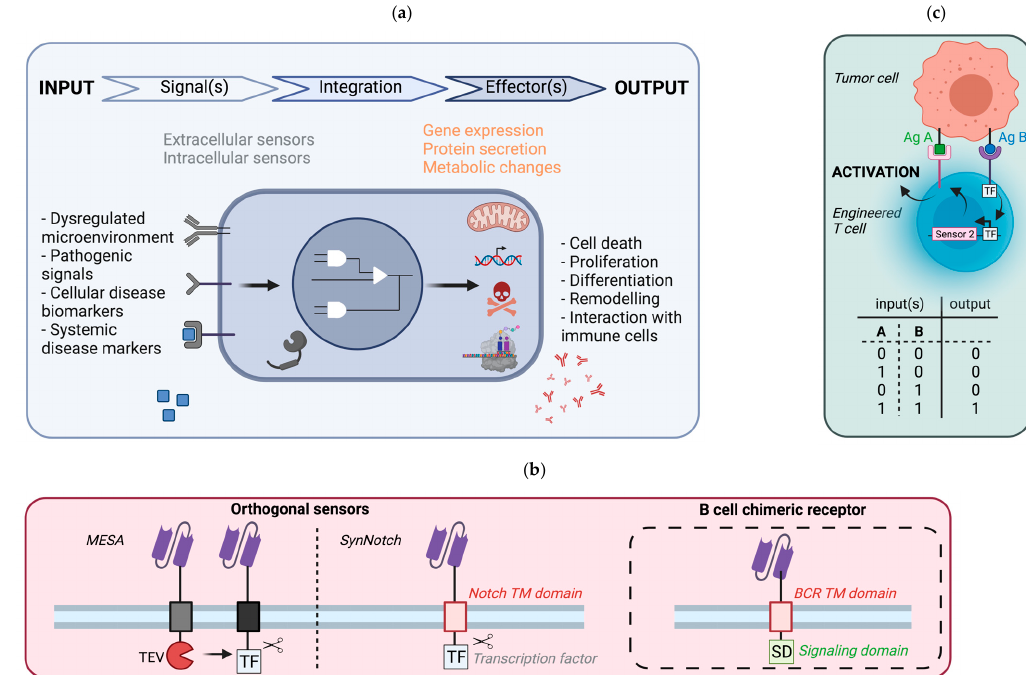
Figure 3. Synthetic immunology approaches applicable to B cell therapies. ( a ) General principle of synthetic regulatory networks. A disruption of homeostasis, such as a local dysregulation, the presence of pathogenic motifs or disease biomarkers, can be recognized by dedicated sensors. These sensors transduce the signals by signaling pathways. Depending on the circuit architecture, several signals may be computed to generate different responses depending on the signal strength and/or the combination of signals detected (gene expression, metabolic changes). ( b ) Chimeric synthetic sensors transposable for the regulation of synthetic networks in B cells. The MESA approach relies on two sensors, both having ScFv domains for target recognition and the CD28 transmembrane domain, but differing in their intracellular parts: one contains the TEV protease, while the other harbors a TEV cleavage site before an ectopic transcription factor. Upon the binding of the target antigen, the transcription factor is released by cleavage on the TEV site. Similarly, the SynNotch sensor is composed of ScFv fragments for the recognition of the target, and fused to the transmembrane domain of the Notch receptors linked to an ectopic transcription factor (middle). Upon the binding of the antigen, a mechanical force triggers the release of the orthogonal transcription factor (the Notch receptor is naturally cleaved after the binding with its ligand Delta), which activates the transcription of a transgene inserted under the control of a promoter sensitive to this transcription factor (ectopically provided). Chimeric BCR sensors combine the extracellular ScFv fragments (for recognition) and the BCR transmembrane regions fused to the intracellular of the Igb (CD79b) signaling domain (right). ( c ) AND-gate circuit regulation. Complex circuits with Boolean gates have been developed to refine the response depending on several input cues. An AND-gate has been developed to trigger T cell activation only if two tumor antigens are detected. When the first sensor, constitutively expressed, recognizes the antigen A, it triggers the expression of the second sensor that recognizes the antigen B, and this second recognition leads to T cell